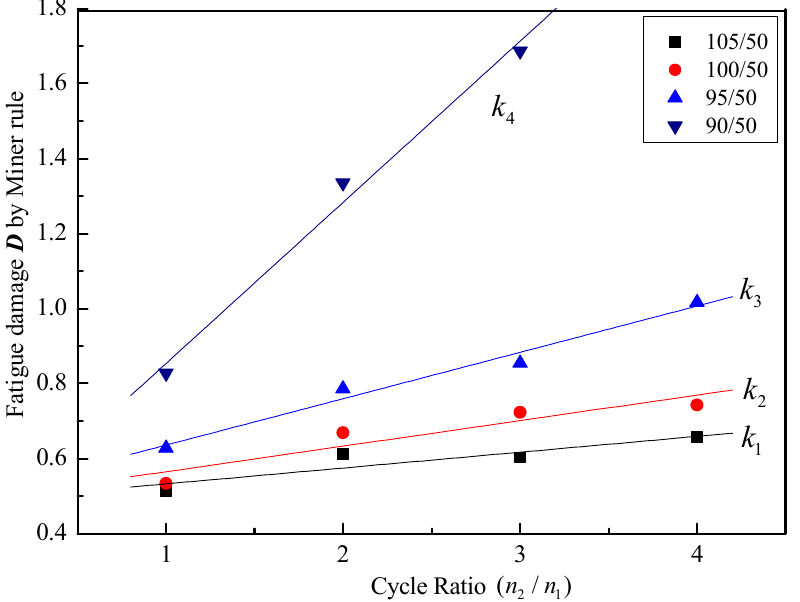
Figure 10. Fatigue cumulative damage of designed T-type specimens under different cycle ratios.